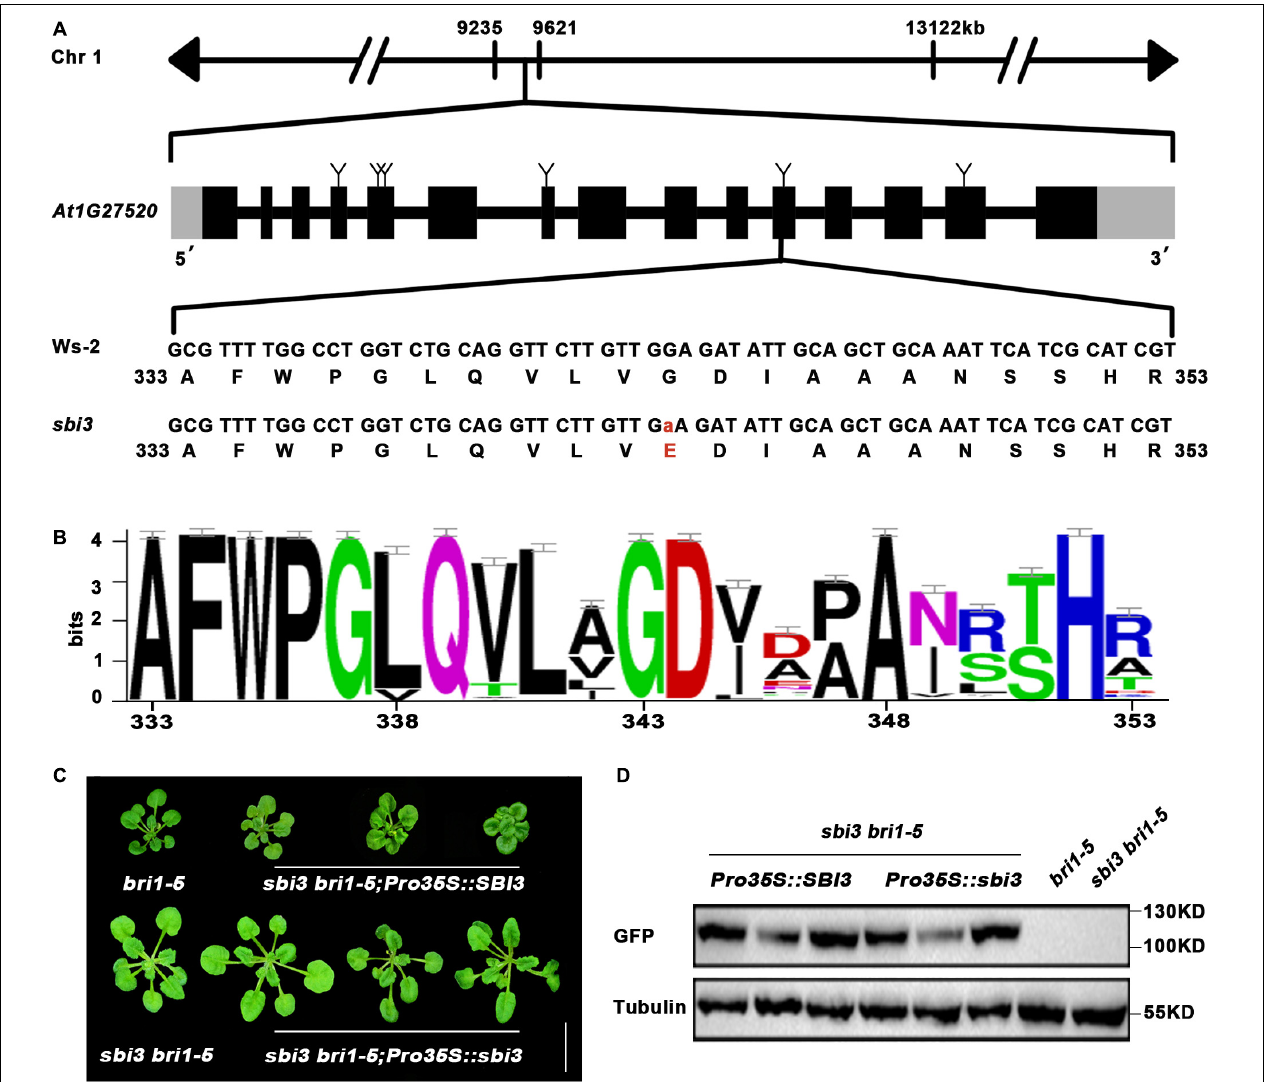
FIGURE 3 | The molecular cloning of sbi3. (A) Schematic presentation of the mutation site in sbi3 . (B) Sequence alignment of a small part of the SBI3 protein among different species. G residue at the 343rd position was highly conserved. (C) Three weeks-soil-grown plants of bri1-5 , sbi3 bri1-5 , three SBI3 -complemented sbi3 bri1-9 transgenic lines carrying an SBI3 transgene driven by the 35S promoter, and three independent sbi3 overexpression transgenic lines on sbi3bri1-5 mutants served as control. Scale bar, 1 cm. (D) Protein expression levels of bri1-5 , sbi3 bri1-5, and the corresponding transgenic plants with GFP tag shown in panel (C) were detected with anti-GFP antibody. Tubulin served as the loading